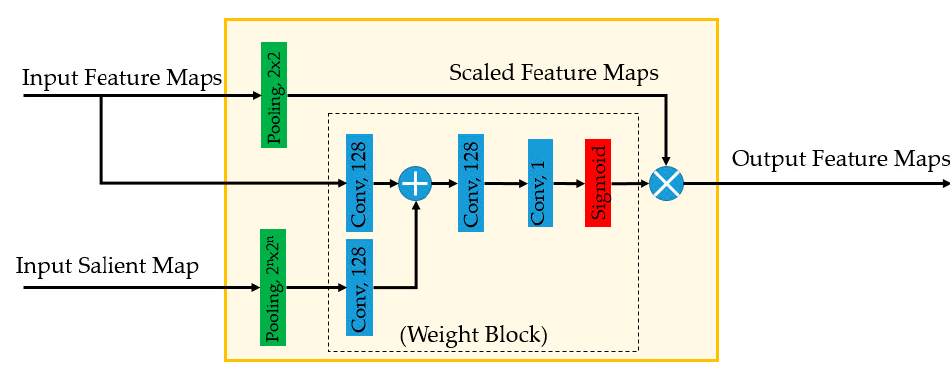
Figure 5. Structure of the attention module.